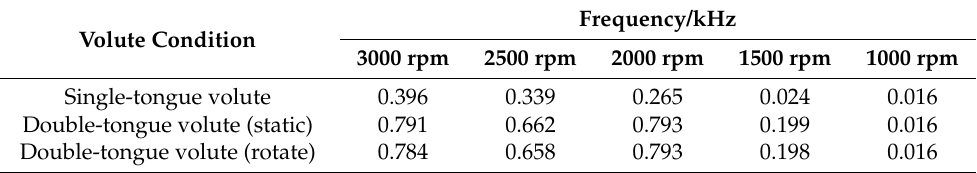
Table 3. Dominant frequency of pressure pulsation at different impeller